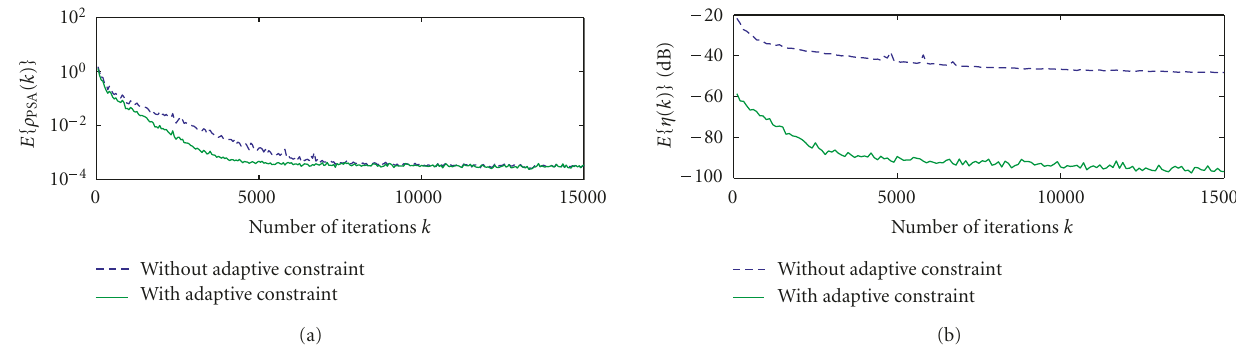
Figure 3: Evolutions of (a) E { ρ PSA ( k ) } and (b) E { η ( k ) } for the spatiotemporal principal subspace